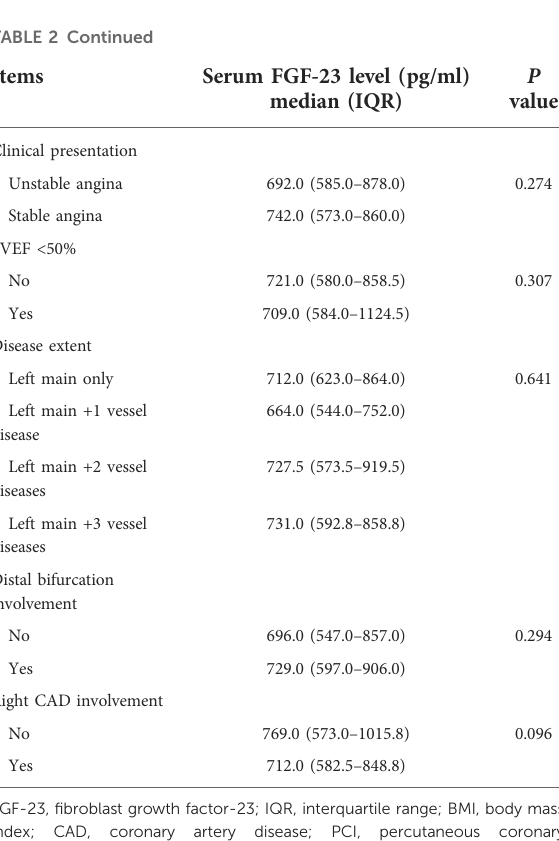
FIGURE 2 Serum FGF-23 level changed before and after coronary artery bypass grafting (CABG) surgery in unprotected left main coronary artery disease patients receiving CABG.